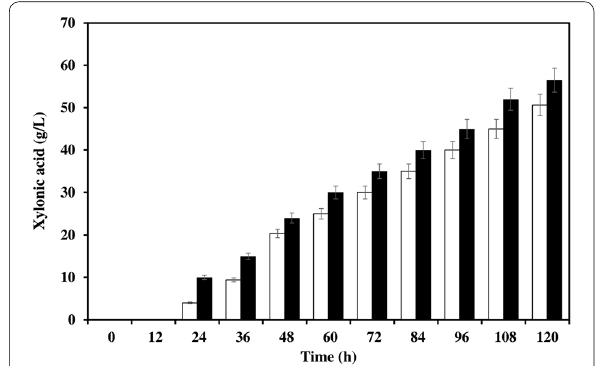
Fig. 3 Xylonic acid production by C. glutamicum ATCC 13032 (open bar) and C. glutamicum ATCC 31831 (closed bar) harbouring plasmid